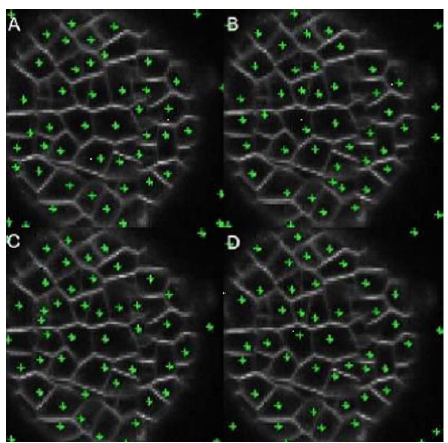
Figure 12. Segmentation results with the Balloon Segmentation for Multicellular Images (BSMI) technique for four different h * l values. ( A ) h * l = 5. ( B ) h*l = 30. ( C ) h*l = 100. ( D ) h*l =150.